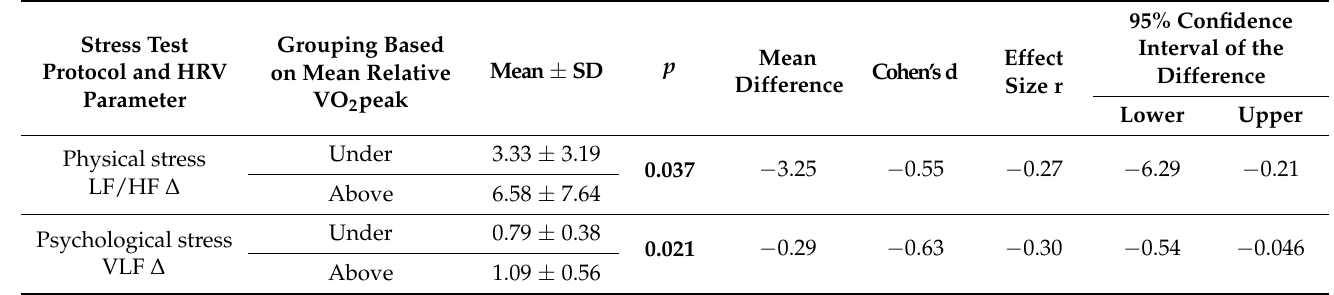
Table 2. Comparison of the changes in LF/HF ratio for the physical test and the changes in the VLF component for the psychological test between the two groups, based on the mean relative VO 2 peak (abbreviations: see Table 1; Bold p -values indicate significant differences).